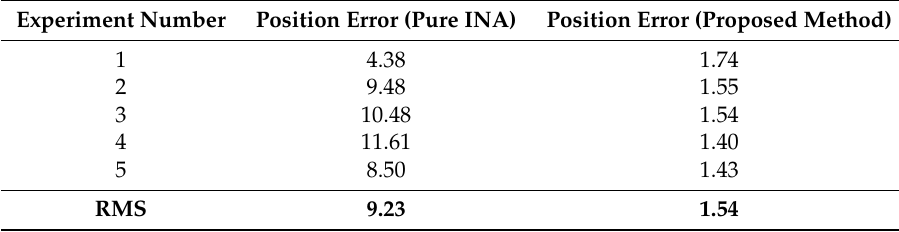
Figure 9. Pedestrian path using the proposed method. Table 1. Final position error comparison in the straight line corridor walking (unit: